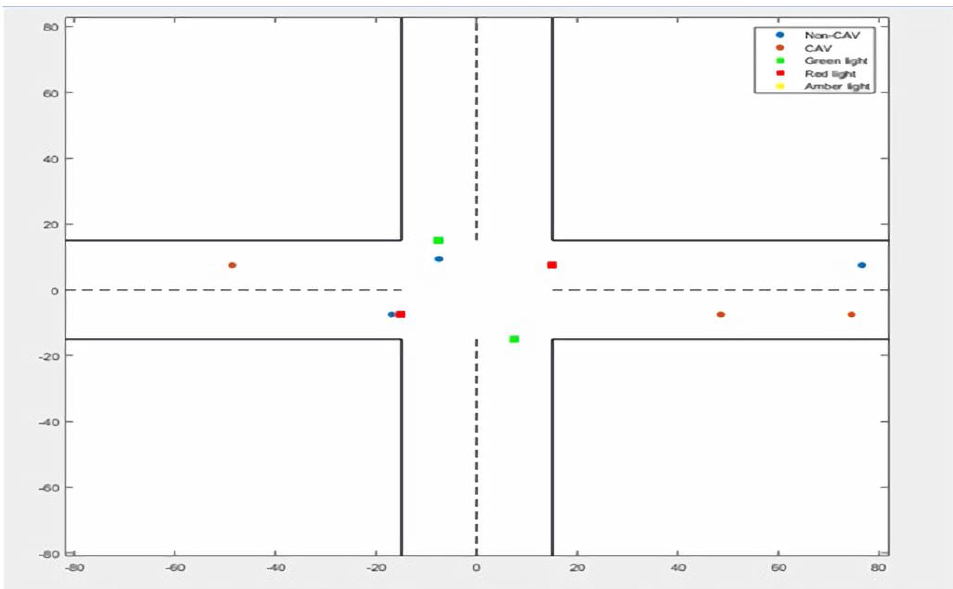
Figure 9. Vehicle moving on the freeway (multilane), connected/linked and automated vehicle, and signals in 3 categories (red, green, and yellow).